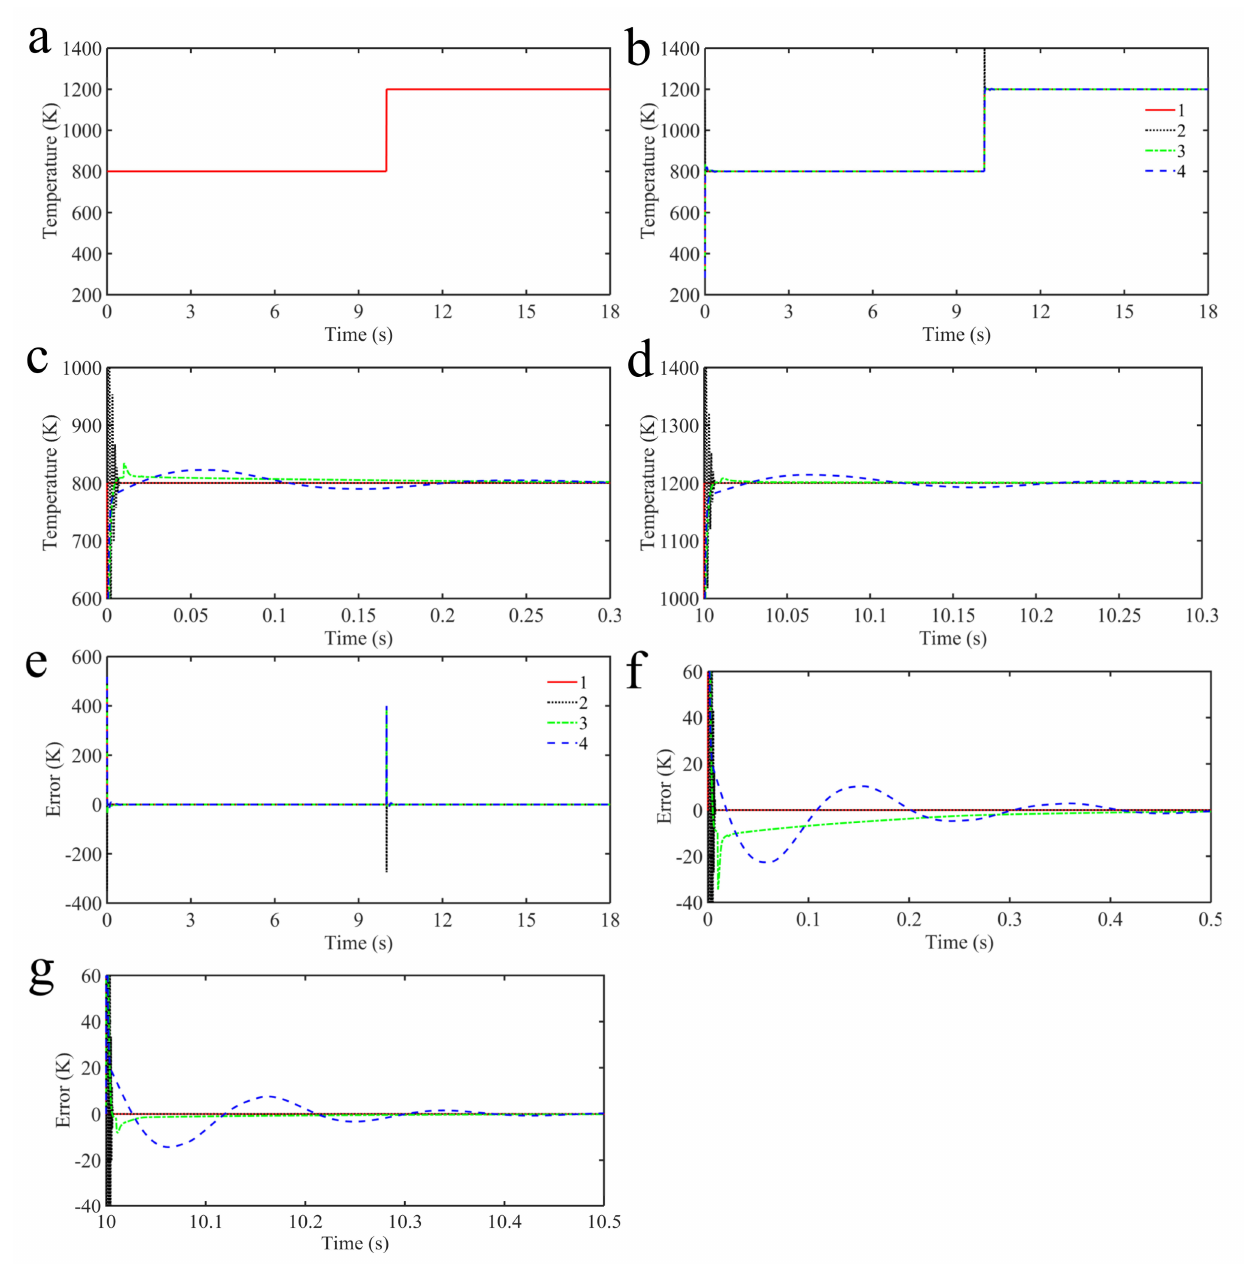
Figure 7. Simulation results without extra disturbances: ( a ) reference step temperature trajectory; ( b ) tracking temperature trajectory; ( c , d ) partial enlarged drawings of tracking temperature trajectory; ( e ) tracking errors; ( f , g ) partial enlarged drawings of tracking errors among (1) STNFOSMCTDE, (2) LFOSMC, (3) IPID and (4)